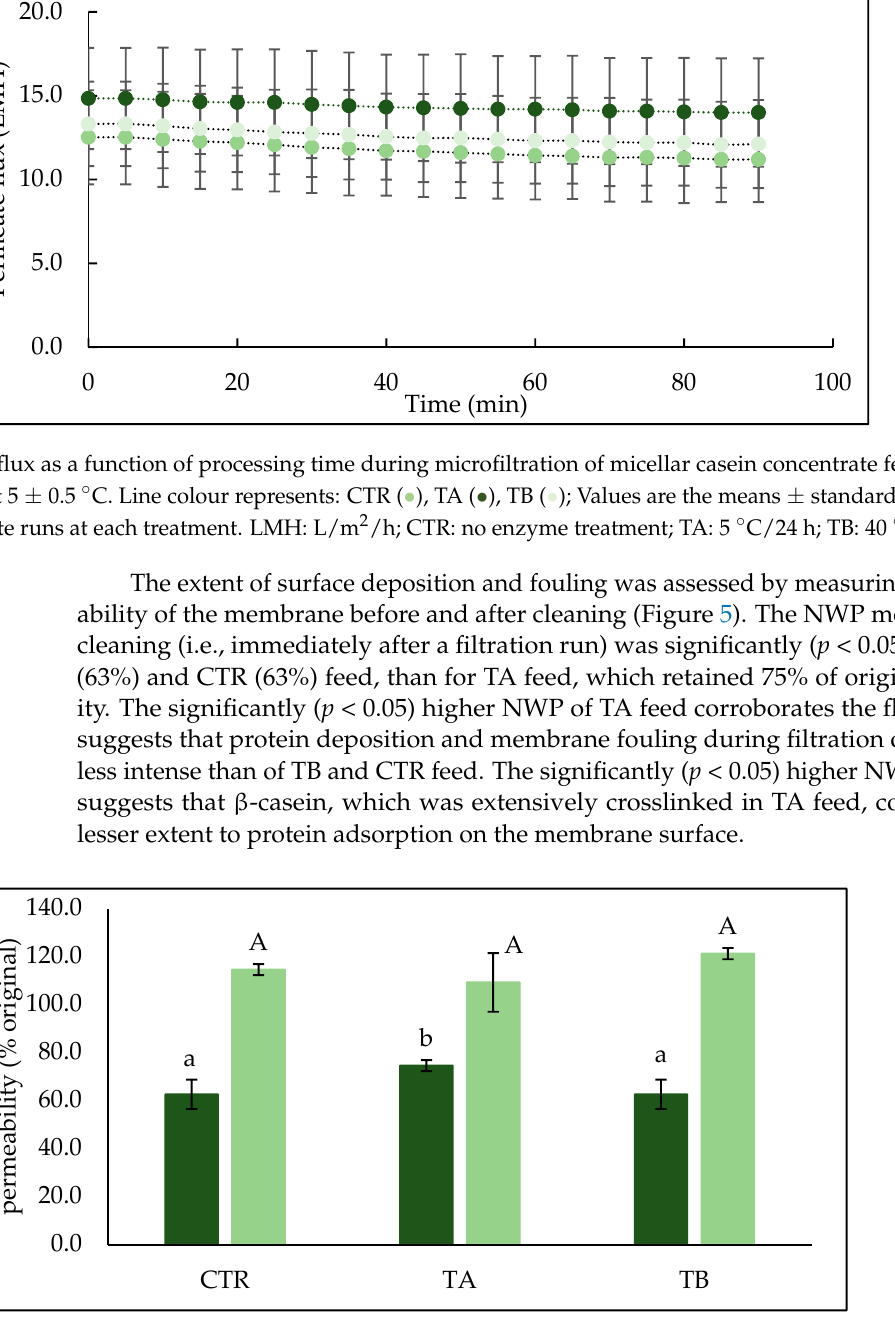
8 of 16 Figure 3. Concentration of κ - casein, α s -casein and β - casein in mTG crosslinked micellar casein concentrate feed used in microfiltration. CTR: no enzyme treatment ( ■) ; TA: 5 °C/24 h ( ■) ; TB: 40 °C/90 min ( ■). Different lower-case letters indicate significant differences ( p < 0.05) between proteins. 3.2. Influence of Feed Crosslinking on Microfiltration Performance The change in permeate flux as a function of filtration time is shown in Figure 4. The permeate flux declined during the first few minutes due to initial deposition [42], which then progressed and declined steadily throughout filtration for all three feeds. This is con- sistent with the findings of Hartinger and Kulozik [18], who also reported steady-state flux decline during cold MF of skim milk. The initial flux was in the range of 12 − 16 L/m 2 /h for all feed samples, which is higher than permeate flux of skim milk, 6 L/m 2 /h, at 4 °C, reported by France et al. [42]. The higher flux in the present study is mainly due to the nature of the starting feed material which was reconstituted micellar casein concentrate with low content of serum proteins which contribute significantly towards resistance to